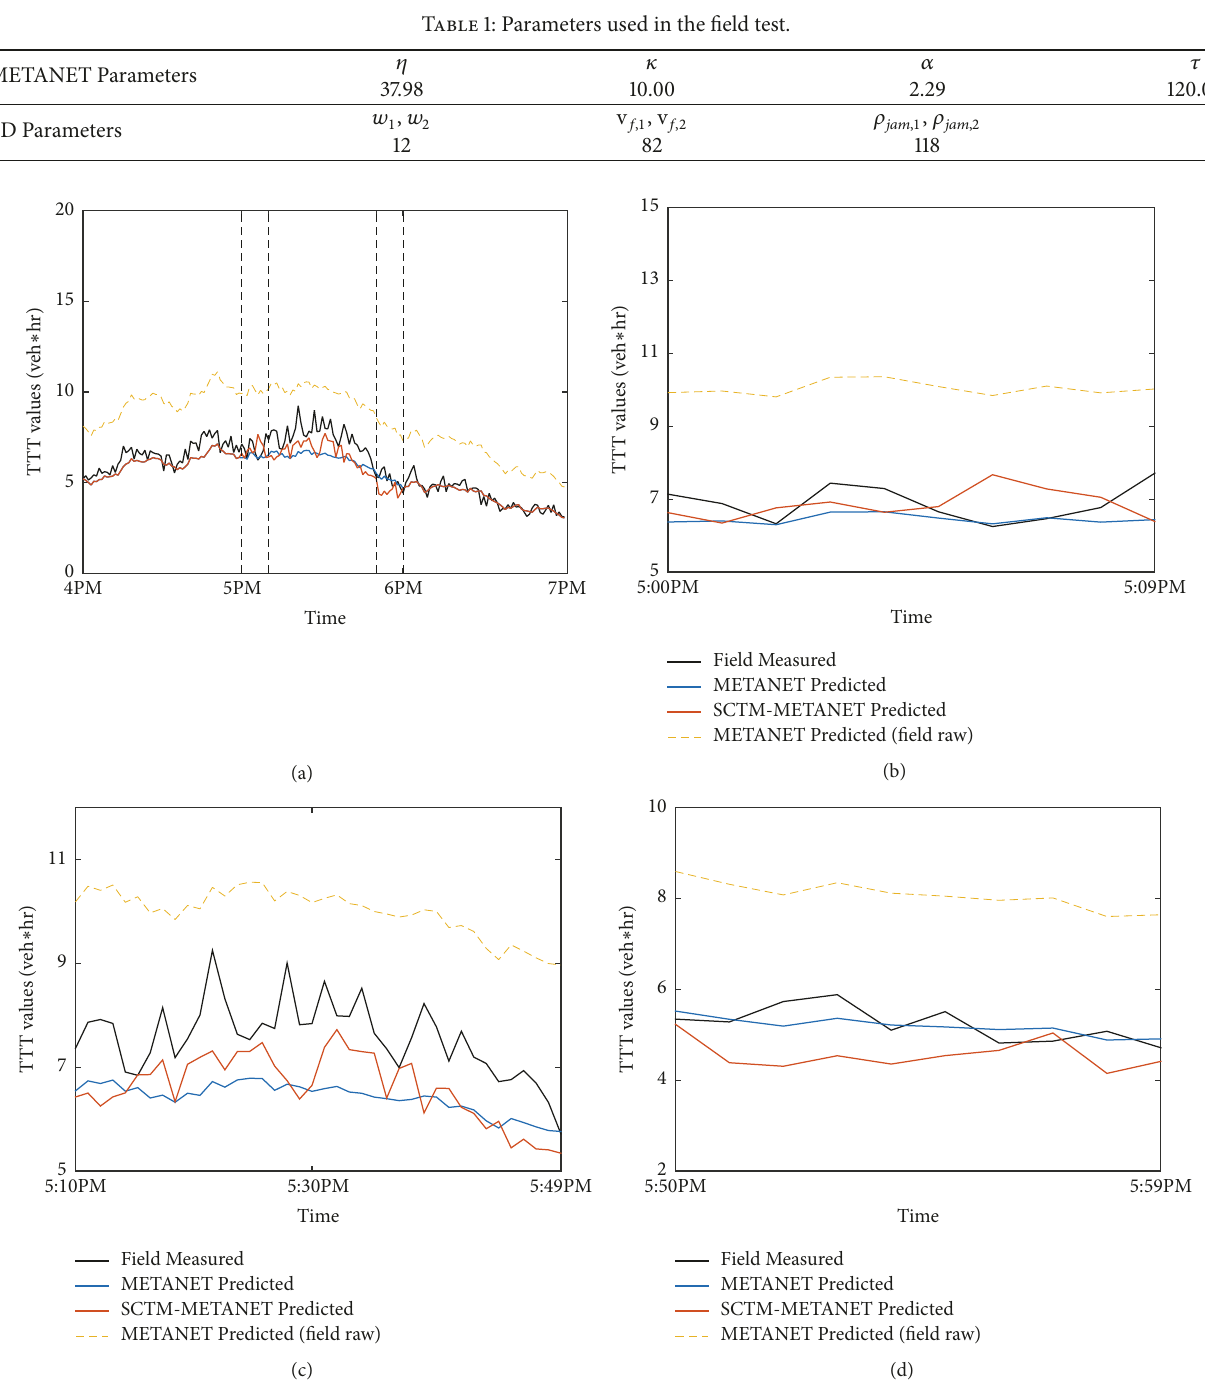
Figure 6: (a) Comparing field-measured TTT, original METANET, and SCTM-METANET predicted TTT; (b), (c), (d) detailed view of FC, CC, and CF